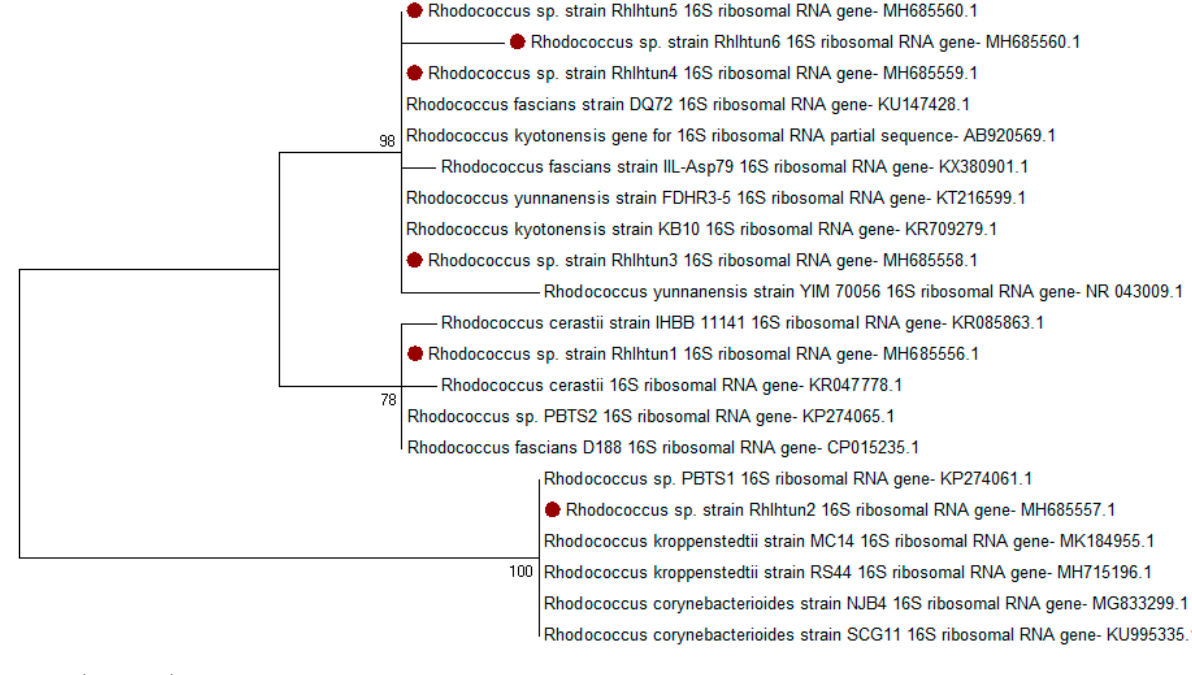
Figure 2. Phylogenetic tree based on the 16S rDNA genes of Rhodococcus spp. (labelled in red points), that were isolated from Iresine herbstii plants in northern Tunisia. The neighbour joining tree based on 16S rRNA was constructed using the Mega software version 6.06, boot- strapped 1,000× with a support threshold of 70%, corresponding to reference sequences with GenBank accession numbers.